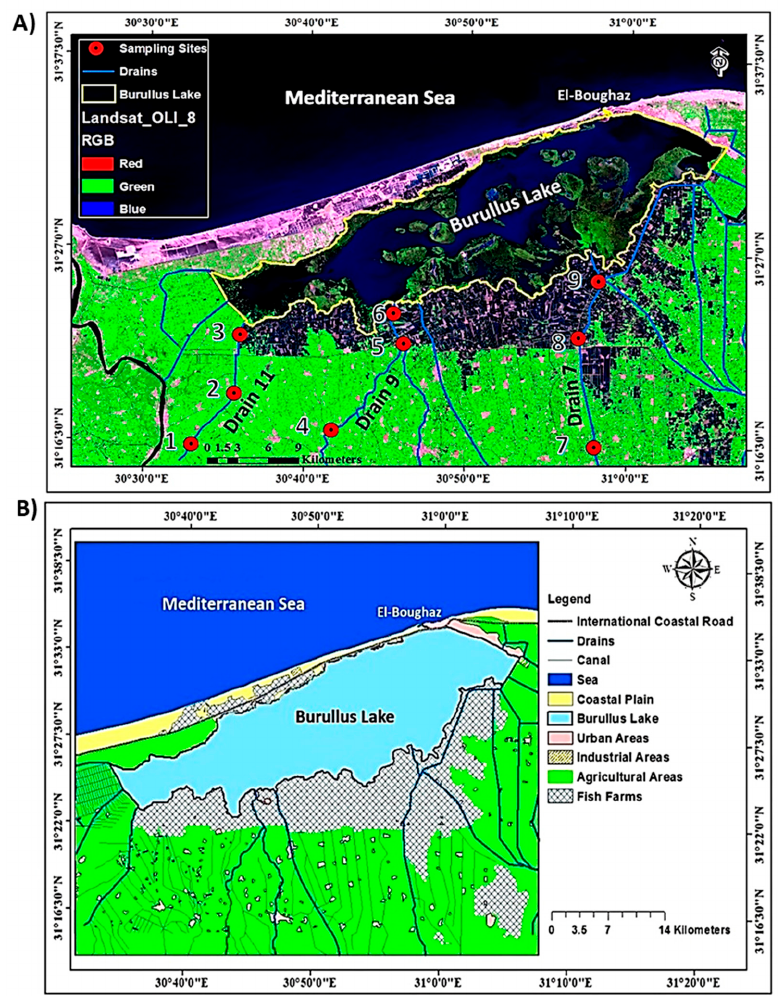
Figure 1 . Location map showing studied sites in the middle Nile Delta. ( A ) the location of the studied sites (1–9) along the three drains. ( B ) land use map of the middle Nile Delta region with various drains discharged into Burullus Lake.